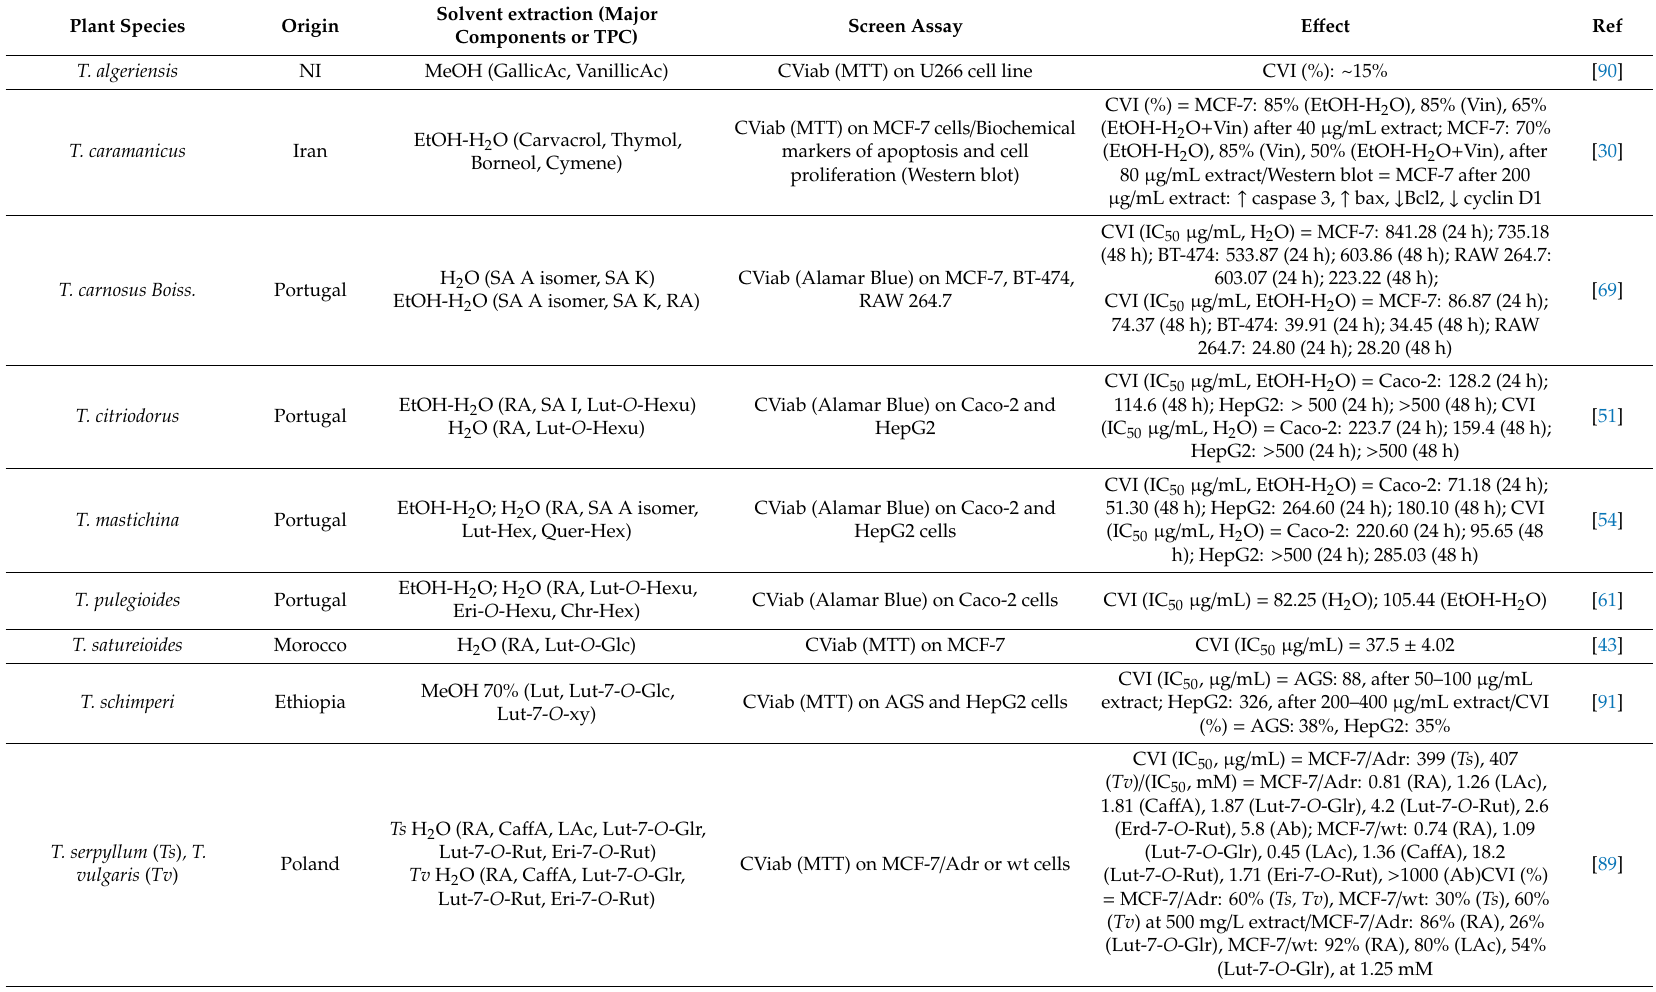
Table 3. Anticancer properties of phenolic-enriched extracts of distinct Thymus